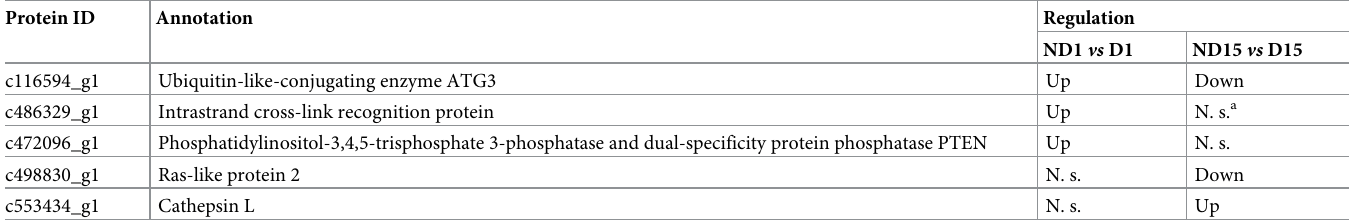
Table 4. DAPs involved with autophagy in ND vs D comparisons based on KEGG analysis. Protein